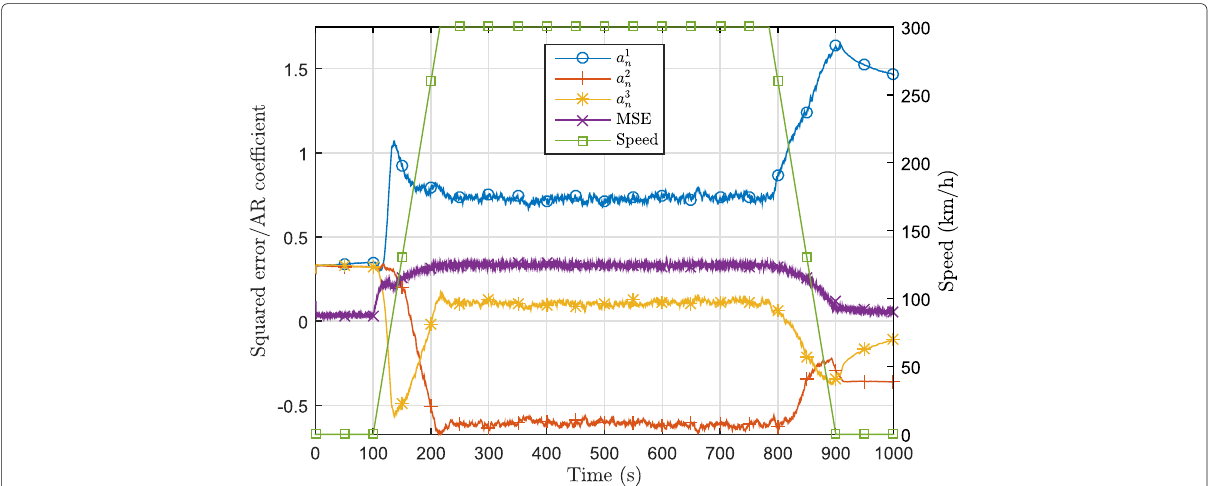
Fig. 12 Example of a simulation with a third-order AR model and the M2 mobility model. SIR is 2.2